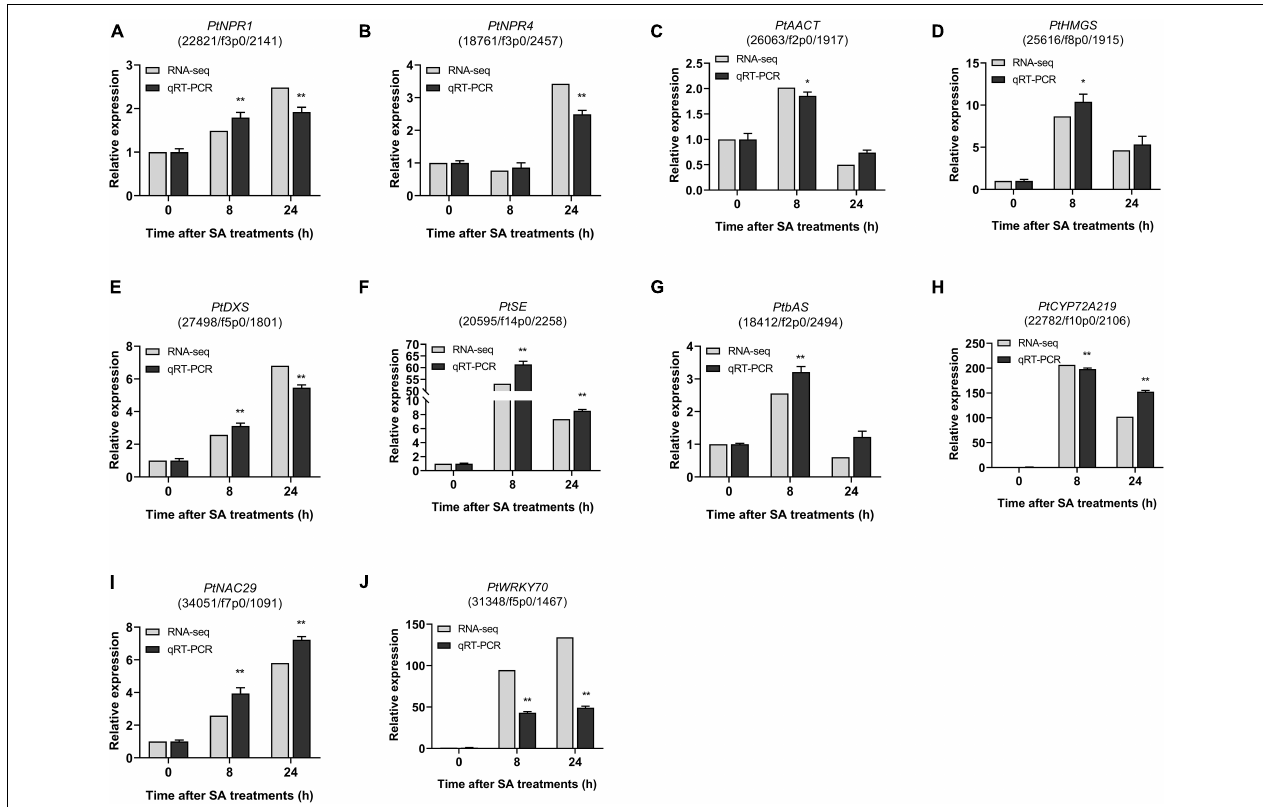
FIGURE 9 | qRT-PCR of candidate genes involved in SA-elicited saponin biosynthesis. The relative expression of ten genes from RNA-seq and qRT-PCR under 0, 8, 24 h of SA treatments. (A) PtNPR1 , (B) PtNPR4 , (C) PtAACT , (D) PtHMGS , (E) PtDXS , (F) PtSE , (G) PtbAS , (H) PtCYP219 , (I) PtNAC29 , and (J) PtWRKY70 . The values represent the mean value ± SE from three biological replicates. *, ** Indicate significant differences in comparison with values of SA_0 h at P < 0.05 and P < 0.01 level ( t -test), respectively.